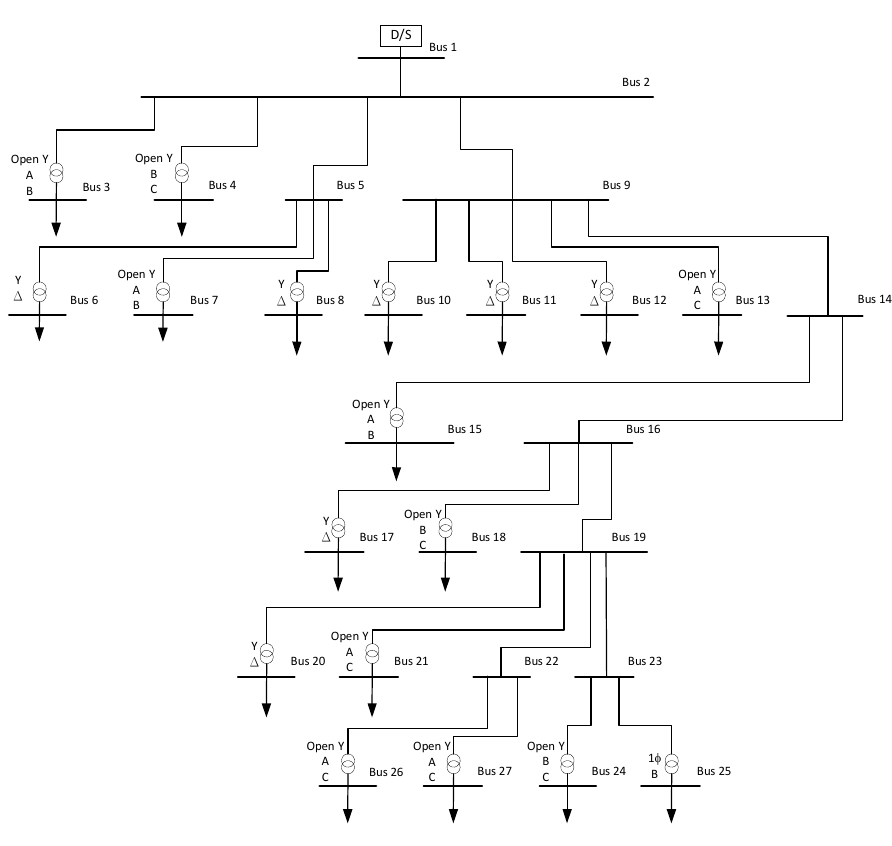
Figure 3. The practical feeder diagram. Table 2. Summary of distribution